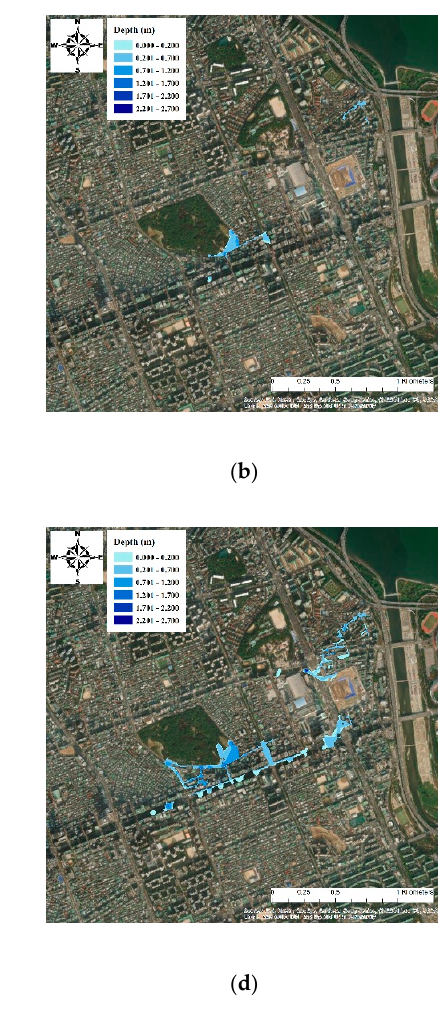
Figure 8. Sample maximum inundation maps applying 100-year, 1-h rainfall events with different Huff quartile distribu- tions (( a – d ): 1st, 2nd, 3rd, and 4th quartile).